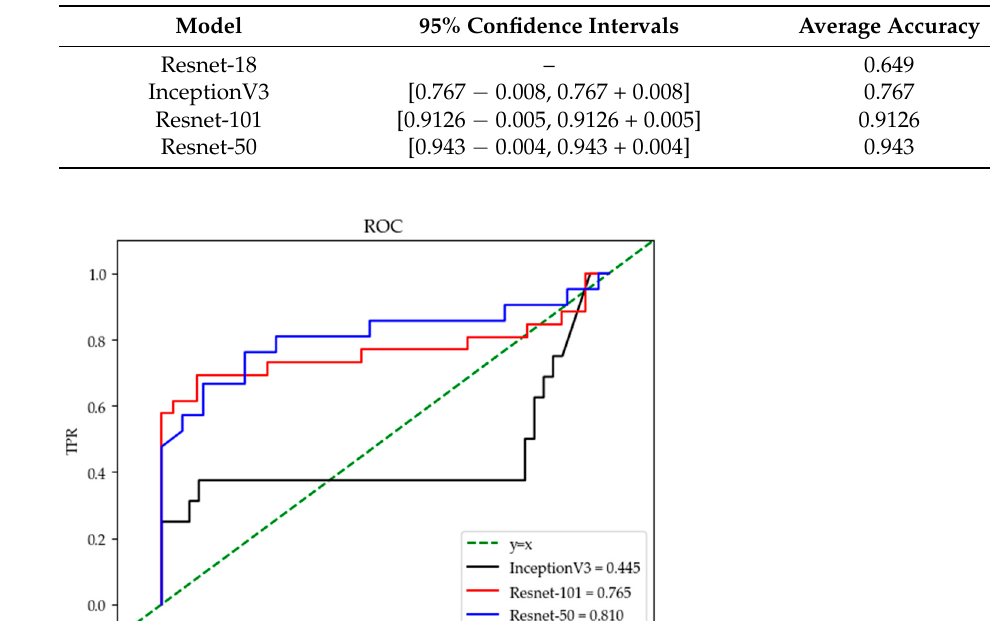
Figure 7. Comparison results of ROC curves for the three models.